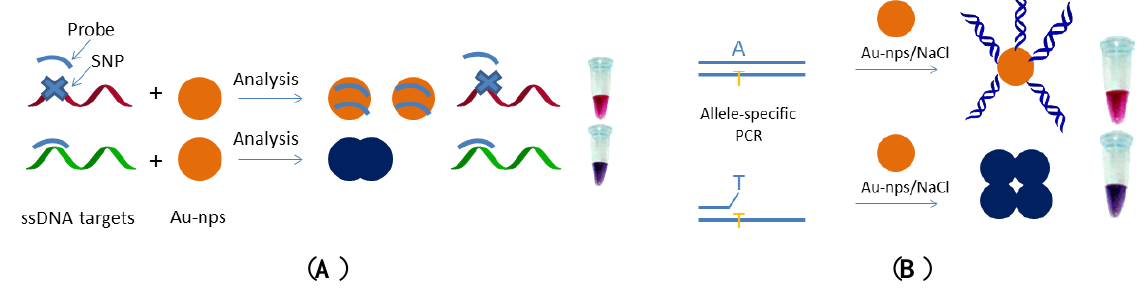
Figure 2. Representative detection of SNPs by modified gold nano-particles (Au-nps) using specific probes binding polymerase-chain reaction (PCR) products ( A ), and allele-specific PCR assay ( B ) [26,27].